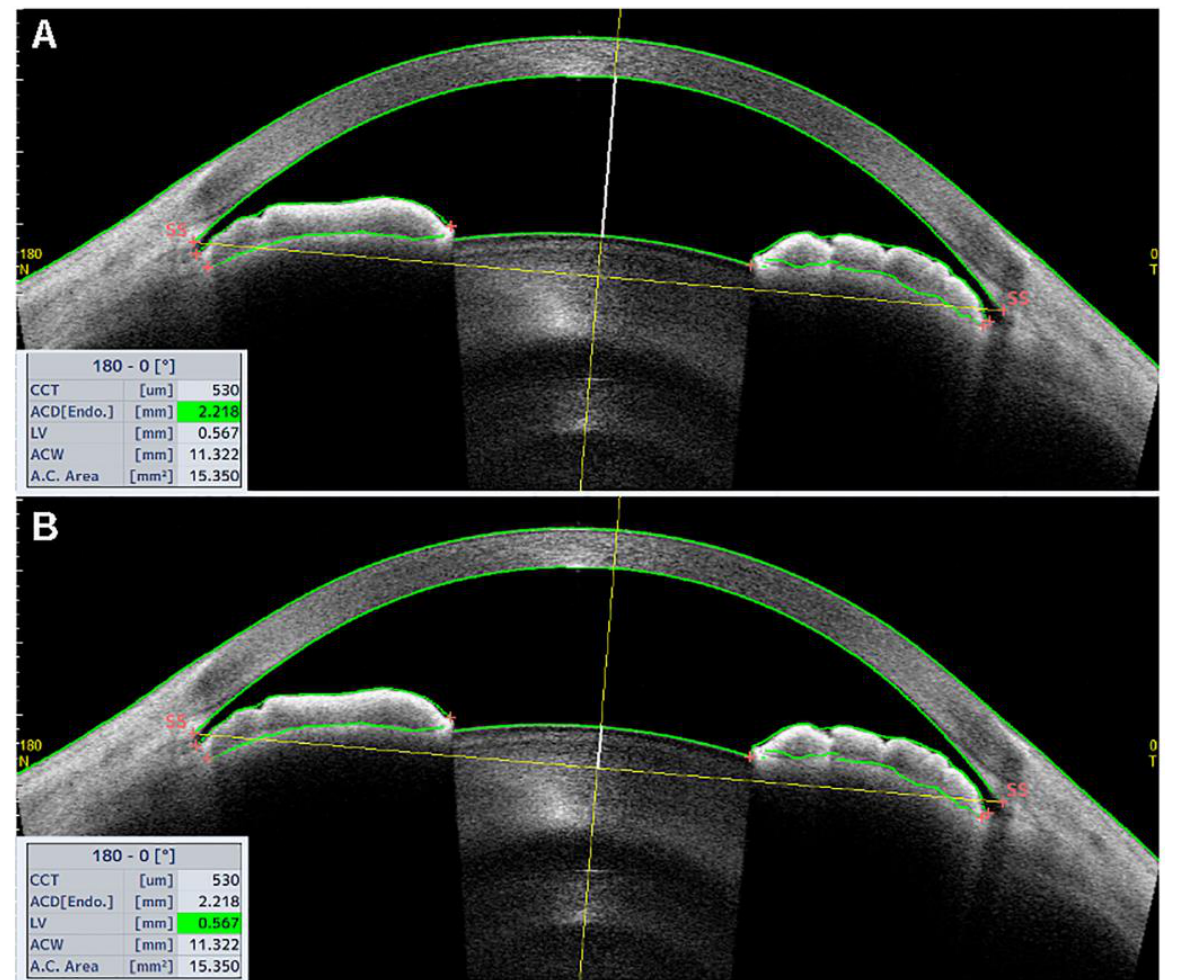
Figure 1. Tomey Casia 2 AS-OCT scan (Nagoya, Japan) of a patient with a narrow angle. ( A ) The white, bold vertical line from the corneal endothelium to the anterior surface of the lens corresponds to the anterior chamber depth (ACD), measuring 2.218 mm in the case reported, as shown in the bottom left table (green highlighted cell). ( B ) The white, bold vertical line from the anterior surface of the lens to the horizontal scleral-spur-to-scleral-spur line corresponds to the lens vault (LV), measuring 0.567 mm in the same patient.